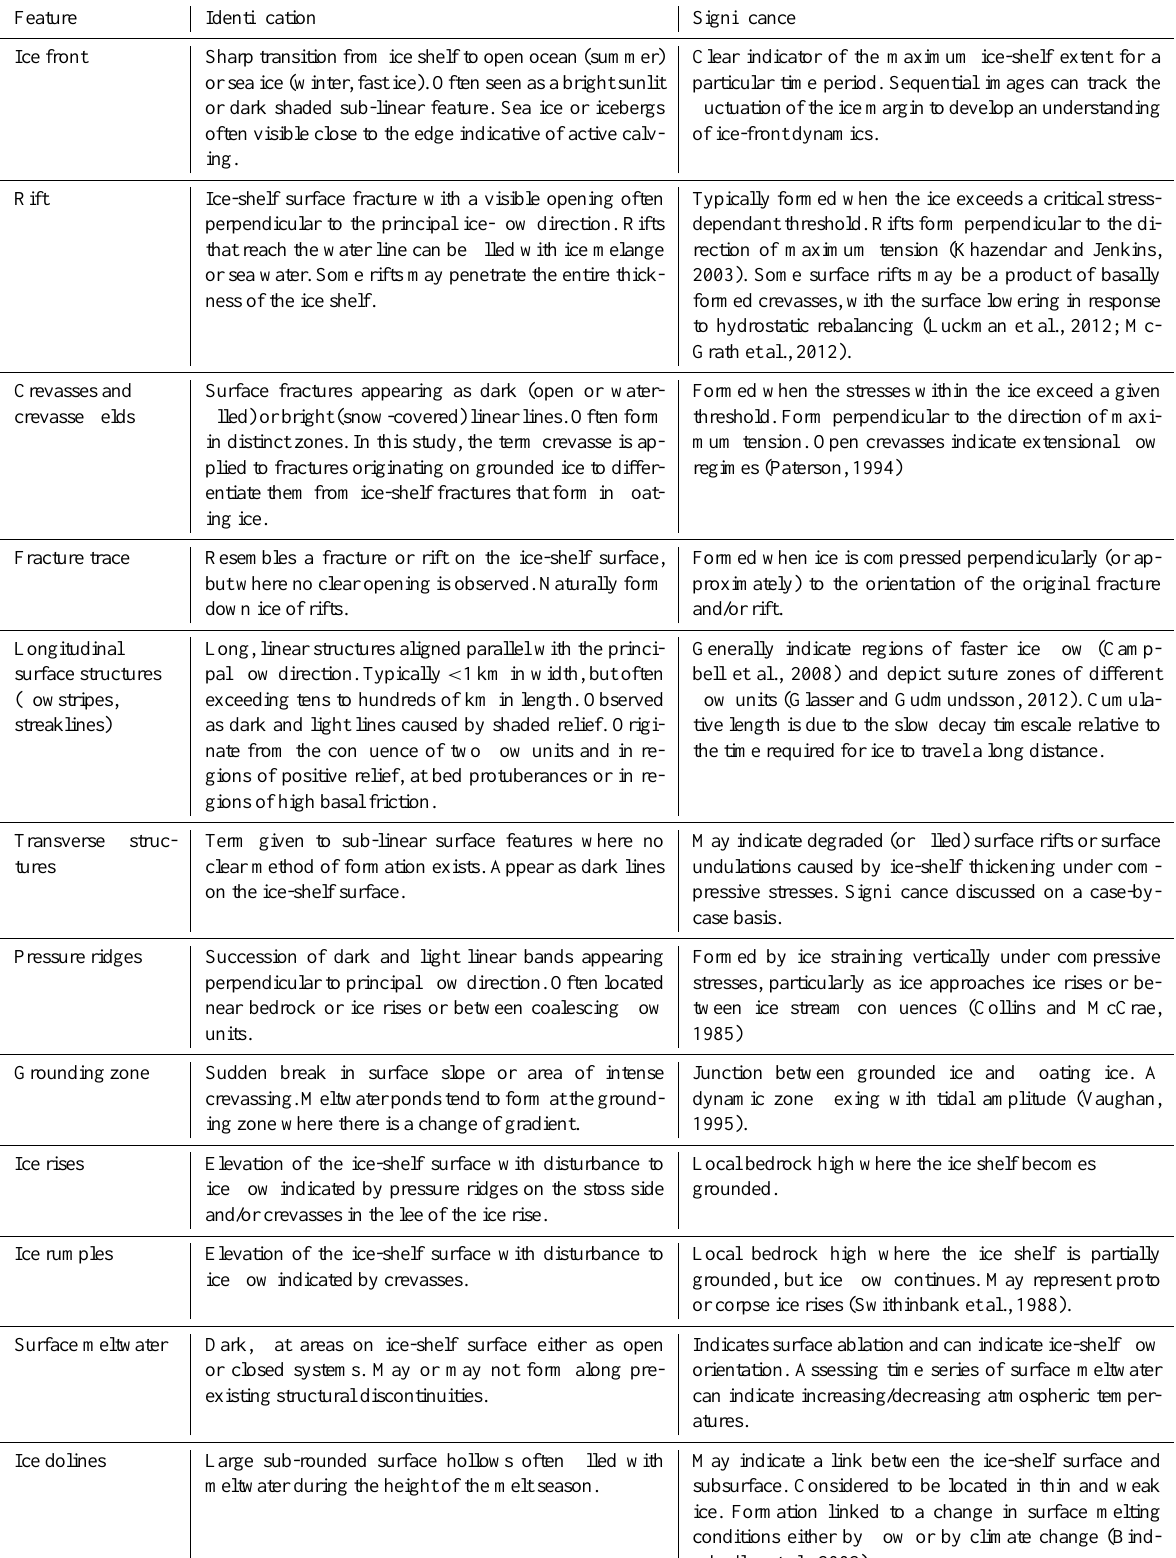
Table 1. Ice-shelf features, identifying criteria and significance. Adapted from Glasser and Scambos (2008) and Glasser et al. (2009). See Fig. 2 for full structural map of GVIIS and Figs. 4 and 5 for the north and south ice fronts,